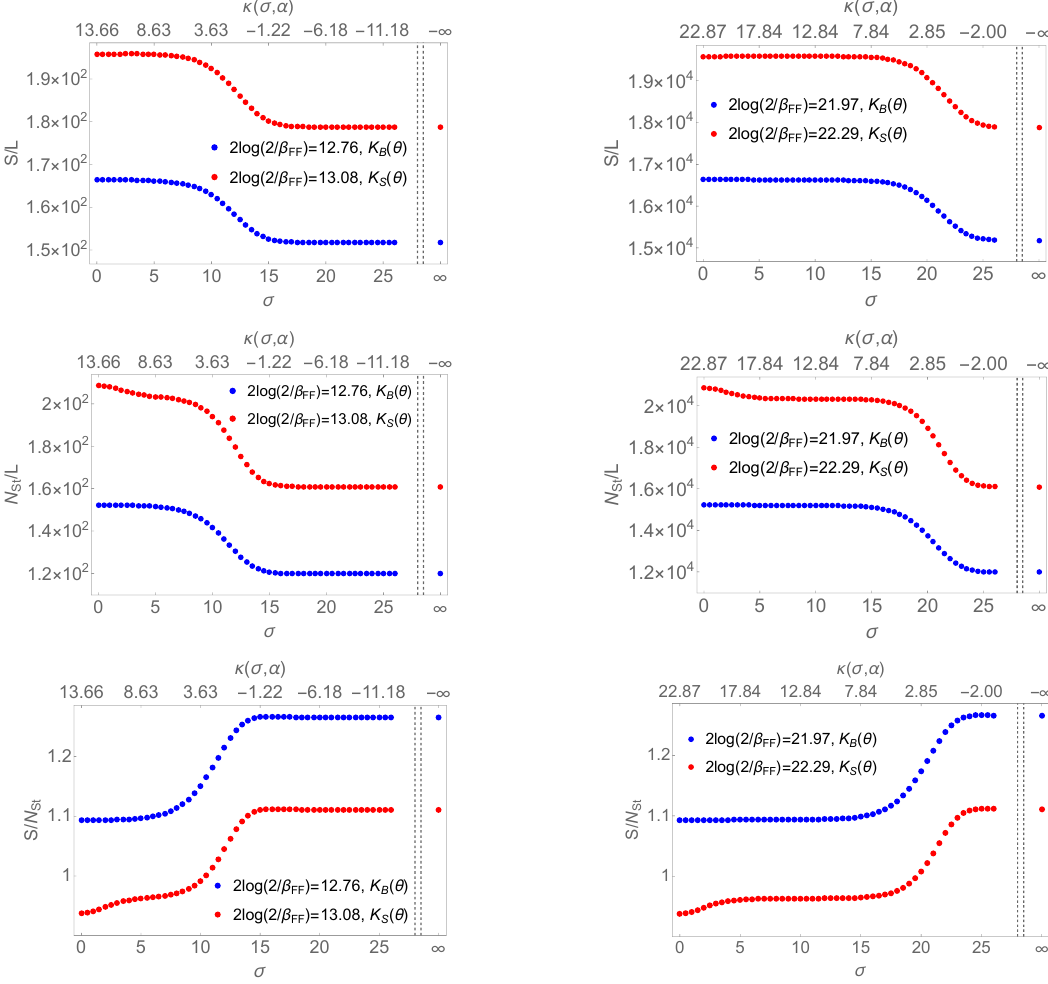
Figure 5 . The entropy density S { L (top), the particle density N st { L (middle) and their ratio (bottom), against the resonance parameter σ for quenches with different K -functions and energy densities (left smaller energy, right larger energy). The injected energy density depends on the free fermion inverse temperature β and on the K -functions ( K in blue, K in red). FF B p θ q S p θ q